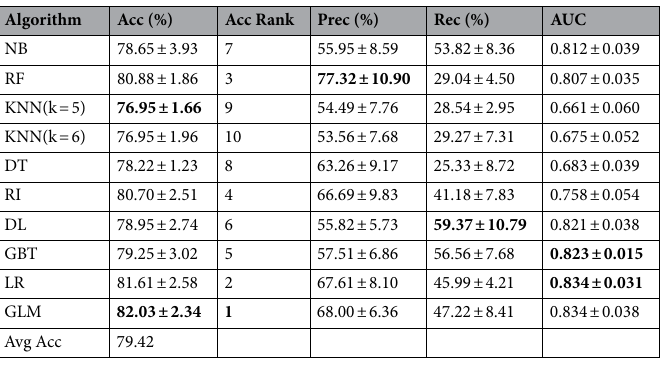
Table 9. The performance of different classification algorithms on 2-class-dataset according to fGOS. Significant values are in bold.